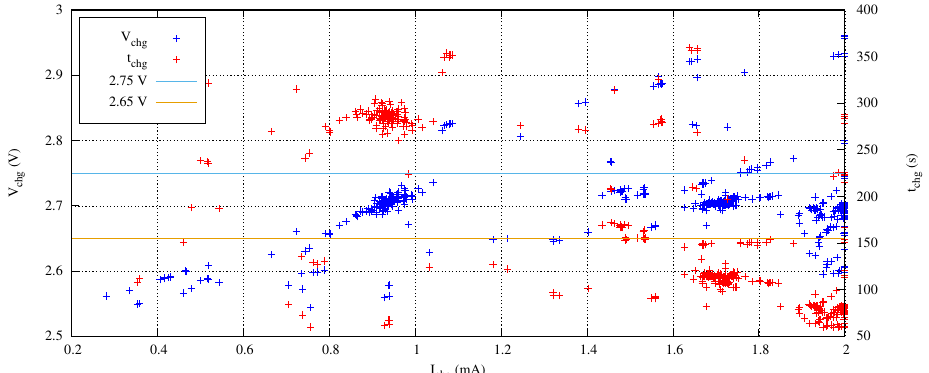
Figure 8. Search coverage of several searches with different seeds.